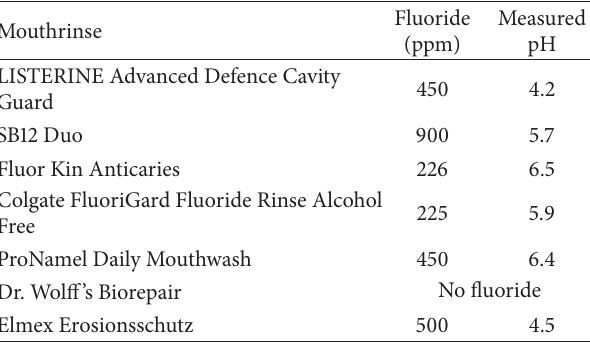
Table 3: Fluoride and pH of mouthrinses assessed in the in vitro EFU and SMH